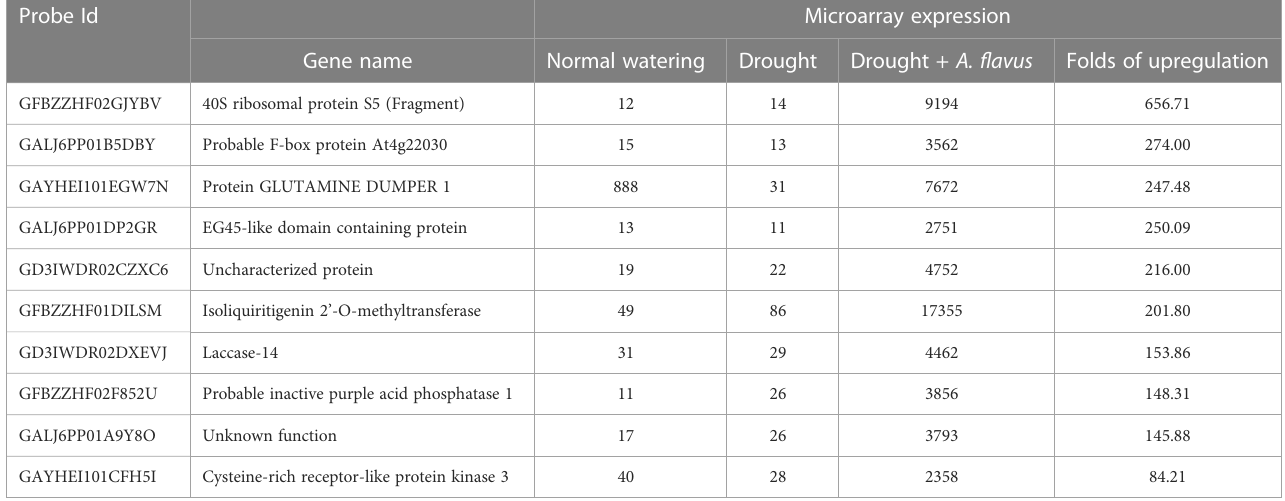
TABLE 1 Microarray expression of some A. fl avus inducible genes. Probe